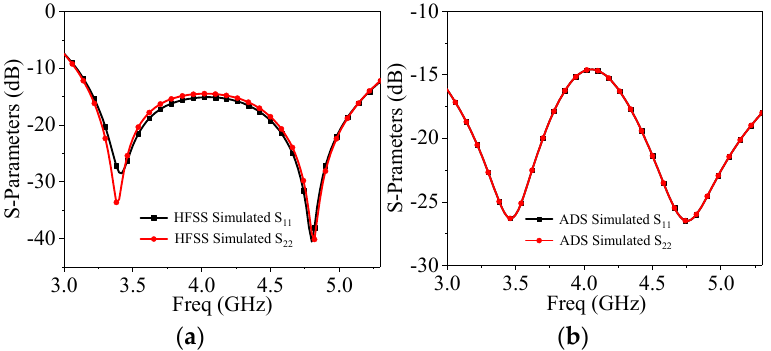
Figure 6. Comparison of simulation results between HFSS and ADS. ( a ) HFSS, ( b ) ADS.